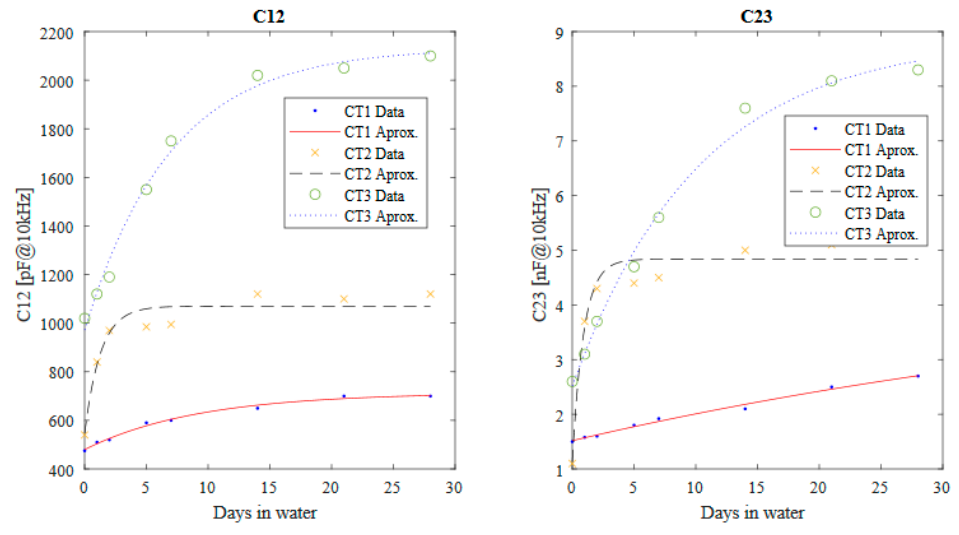
(cid:4666) 𝑡 (cid:4667) for the C 12 and C 23 parameter of all cables.